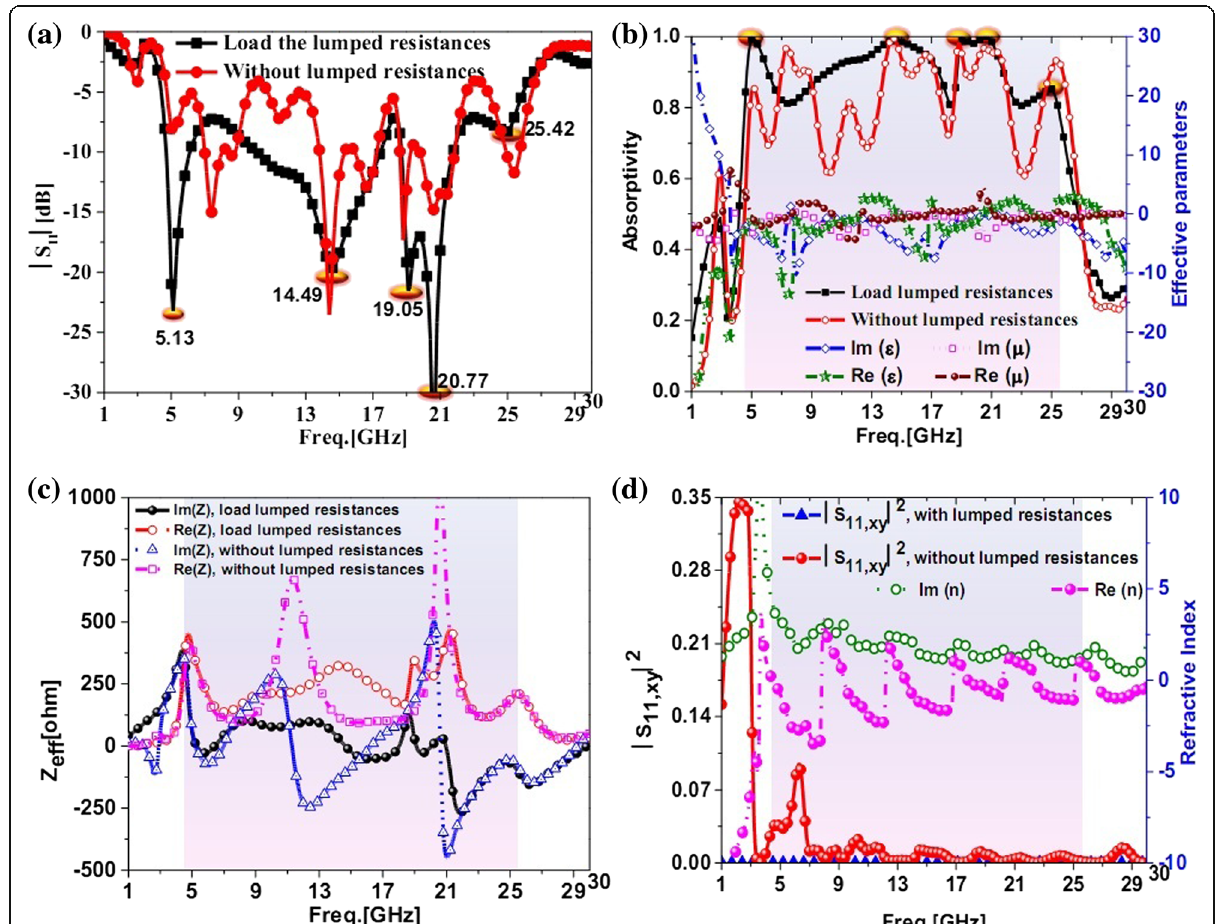
Fig. 2 The simulated |S11|, absorption, effective parameters, effective impedances and refractive index from 1 to 30GHz for the proposed ultra-wideband perfect metamaterial absorber loaded with lumped resistances and the same microstructure without the lumped resistances. a Simulated |S11| results. b Simulated absorption results and effective parameters. c The effective impedances of proposed PMA with lumped resistances and the same microstructure without lumped resistances. d The reflection components of the cross-polarization for the proposed PMA with lumped resistances and the same microstructure without lumped resistances and the refractive index of the presented